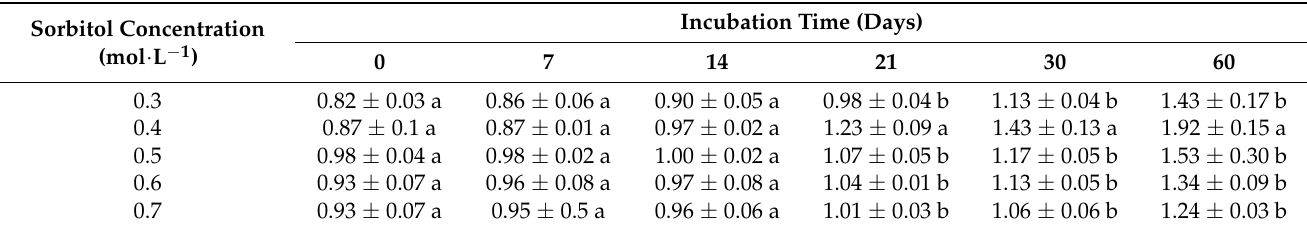
Table 4. Changes in the fresh weight of F. mandshurica embryogenic callus with culture time under different sorbitol concentrations.